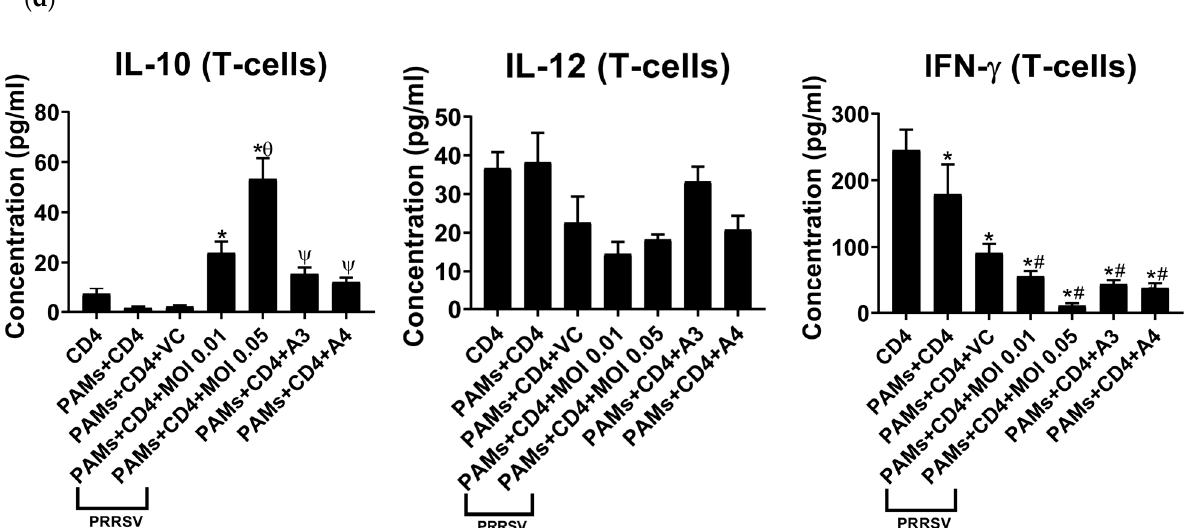
Figure 5. Th1 response modulated by A3-mediated TLR activation. Signature of ( a ) PAMs and ( b ) T-cell compartment in cocultured system by gene profile analysis. Signature of ( c ) PAMs and ( d ) T-cell compartment in cocultured system analyzed by ELISA to determine cytokine levels. Data presented as means ± SEM, calculated from 4 pigs. * p < 0.05 compared to PAM or CD4 + group, # p < 0.05 compared to PAM cocultured CD4 + group (without any challenge or treatment), θ p < 0.05 compared to 0.01 MOI, ψ p < 0.05 compared to 0.05 MOI.